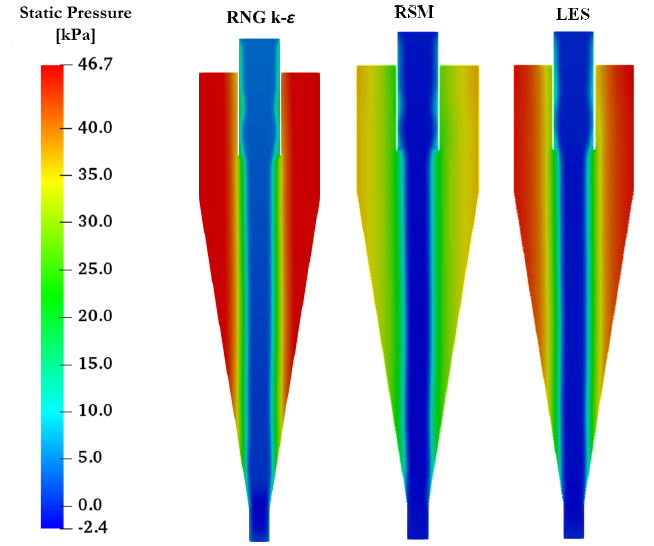
Figure 6. Gradient pressure contours.